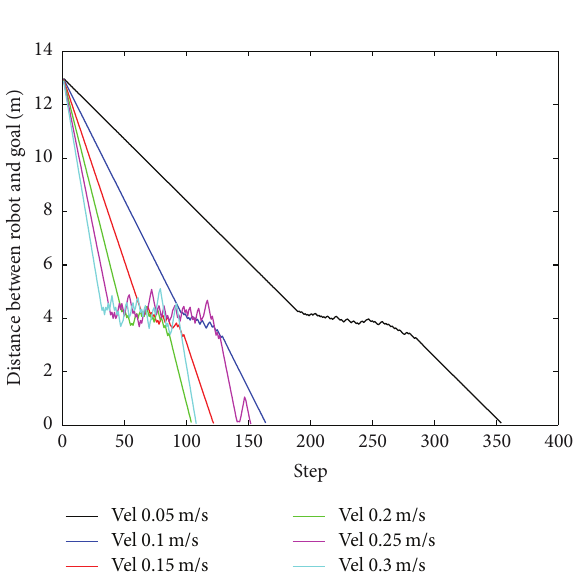
Figure 6: Moving velocity impact on convergence rate.